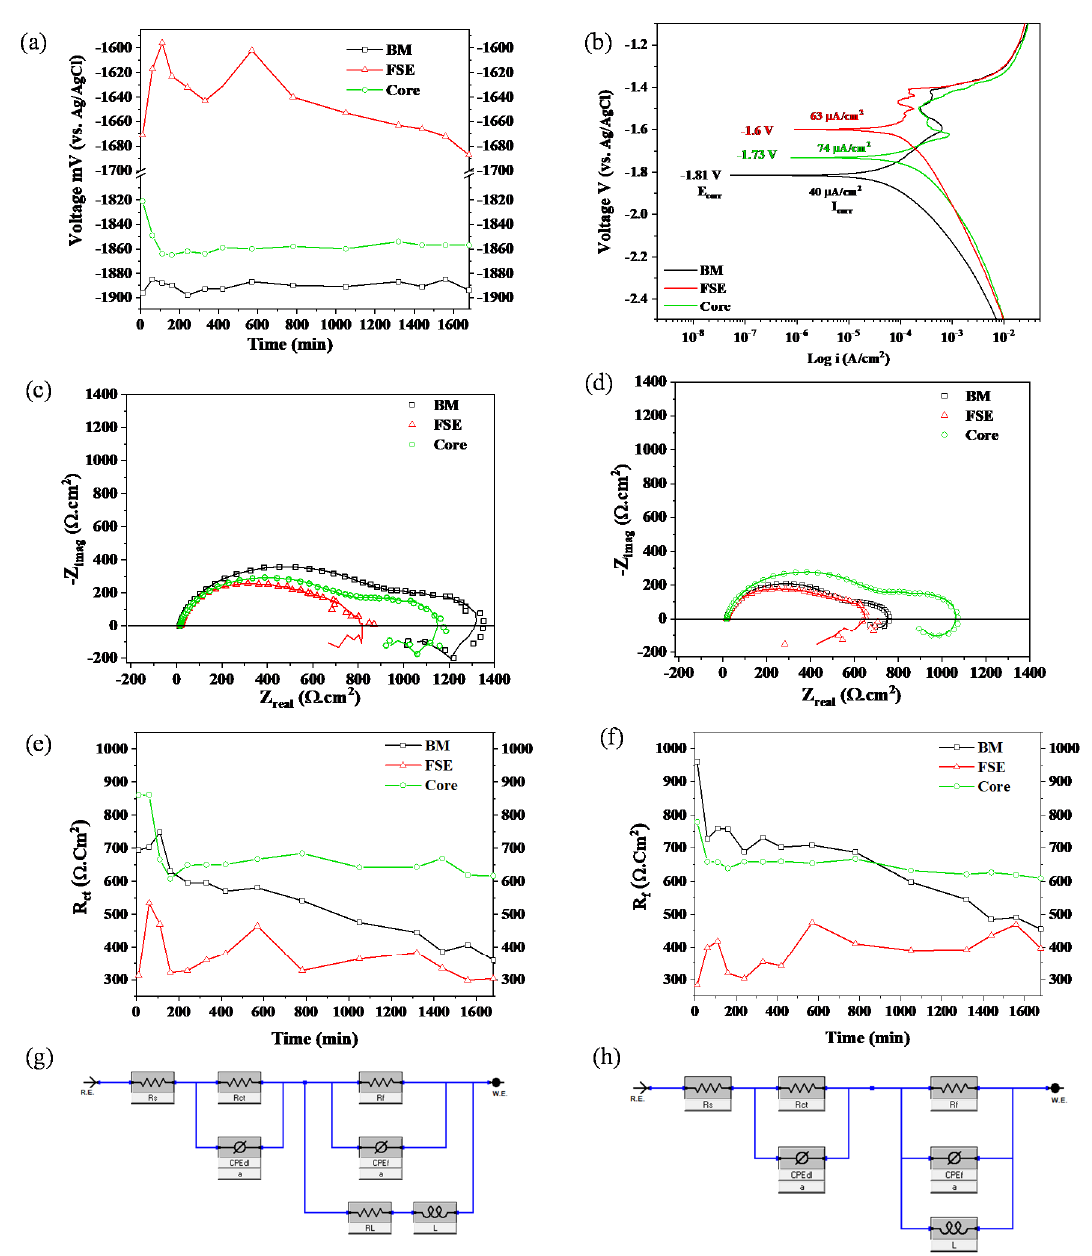
Figure 13. ( a ) Evolution of open circuit potential of BM, FSE, and core, during 1680 min of immersion in HBSS at 37 ± 1 °C. ( b ) Potentiodynamic polarization curves obtained after 30 min of immersion. Evolution of Nyquist plots after ( c ) 110 min and ( d ) 1680 min of immersion. Variation of ( e ) charge transfer resistance and ( f ) film resistance, equivalent circuit utilized for ( g ) BM and core samples, ( h ) FSE sample.